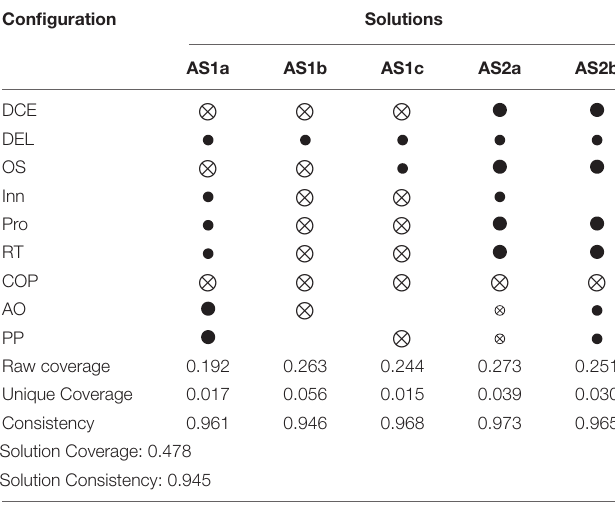
TABLE 4 | Configurations for the absence of middle management team innovativeness (fuzzy-set qualitative comparative analysis).